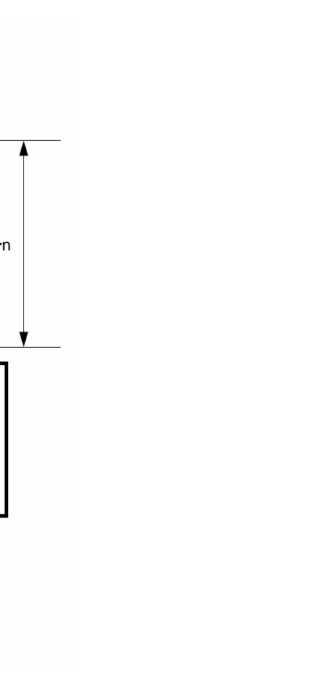
Figure 1. Thermoelectric couple operating as a